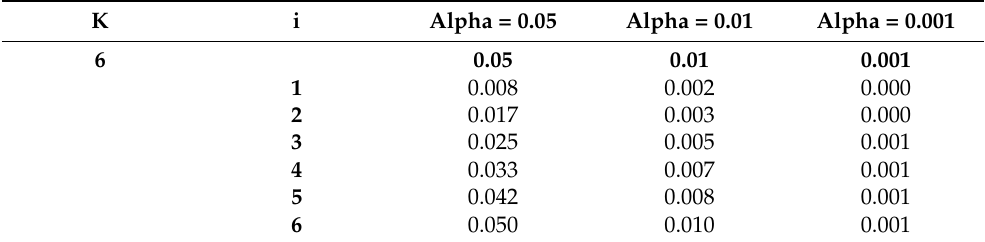
Table 2. Benjamini–Hochberg correction for multiple comparisons: Comparison of microRNA gene expression between various groups of pregnant women (normal pregnancies vs. chronic hypertension vs. GH vs.